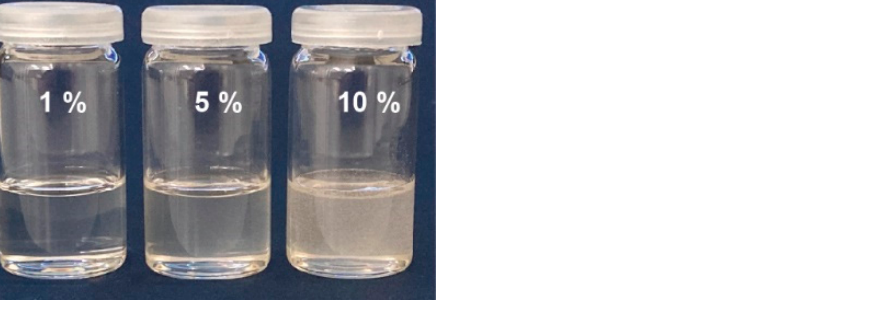
Table 1. Recovery rate of silk fibroin after dissolution in ZnCl 2 (56% w / w ) and desalting using gel